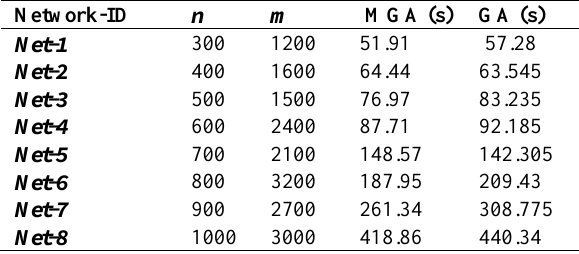
Table 3. Total running times of GA, MGA on random